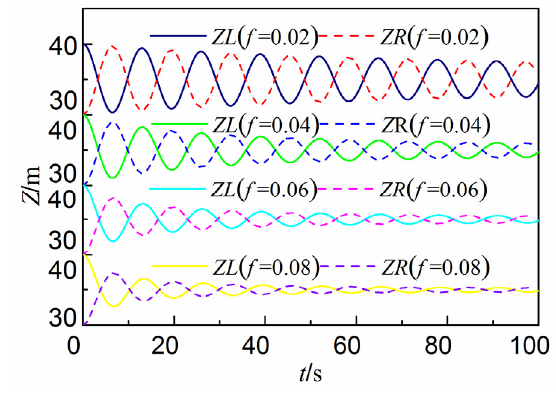
Figure 17. Water level traces when neglecting friction.